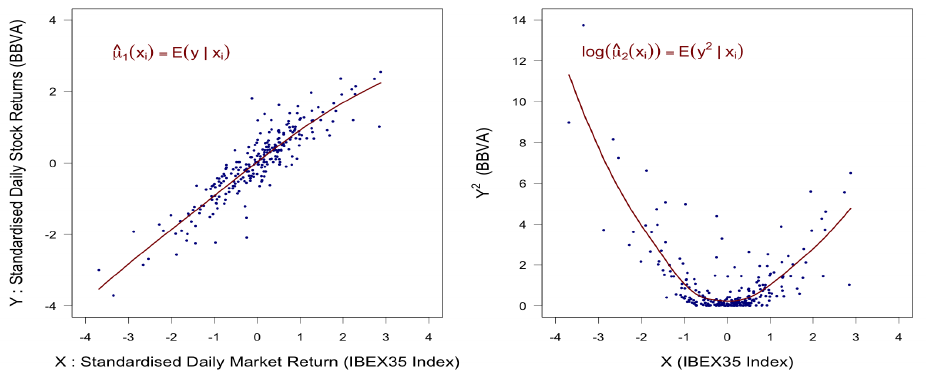
Figure 3. Estimates ˆ µ 1 , (cid:100) log µ 2 for BBVA stock returns as functions of IBEX35.